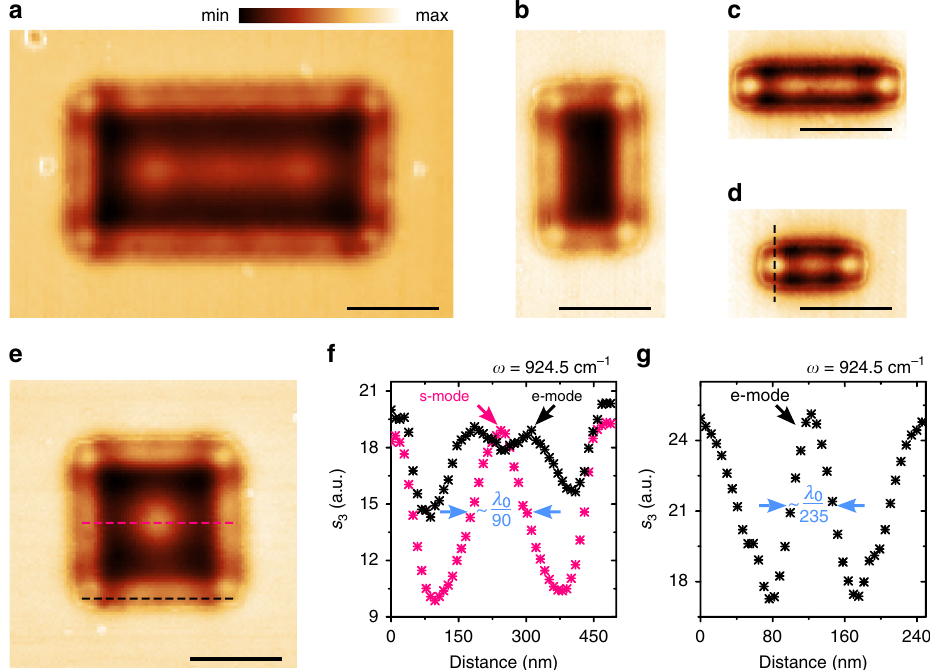
Fig. 2 Highly con fi ned surface polariton modes on 7-nm-thick germanium nanoresonators. a – e s-SNOM images recorded at ω ¼ 924.5 cm − 1 for 1000 × 500, 300 × 500, 500 × 100, 300 × 100 and 500 × 500 nm structures correspondingly. f Cross-sections along dashed lines in image e showing near- fi eld amplitude ( s 3 ) distribution. Pink and black colours represent sheet and edge modes correspondingly. g Optical cross-section along black dashed line in image d . Colour bar in panel a is the same for all images. All scale bars are 300